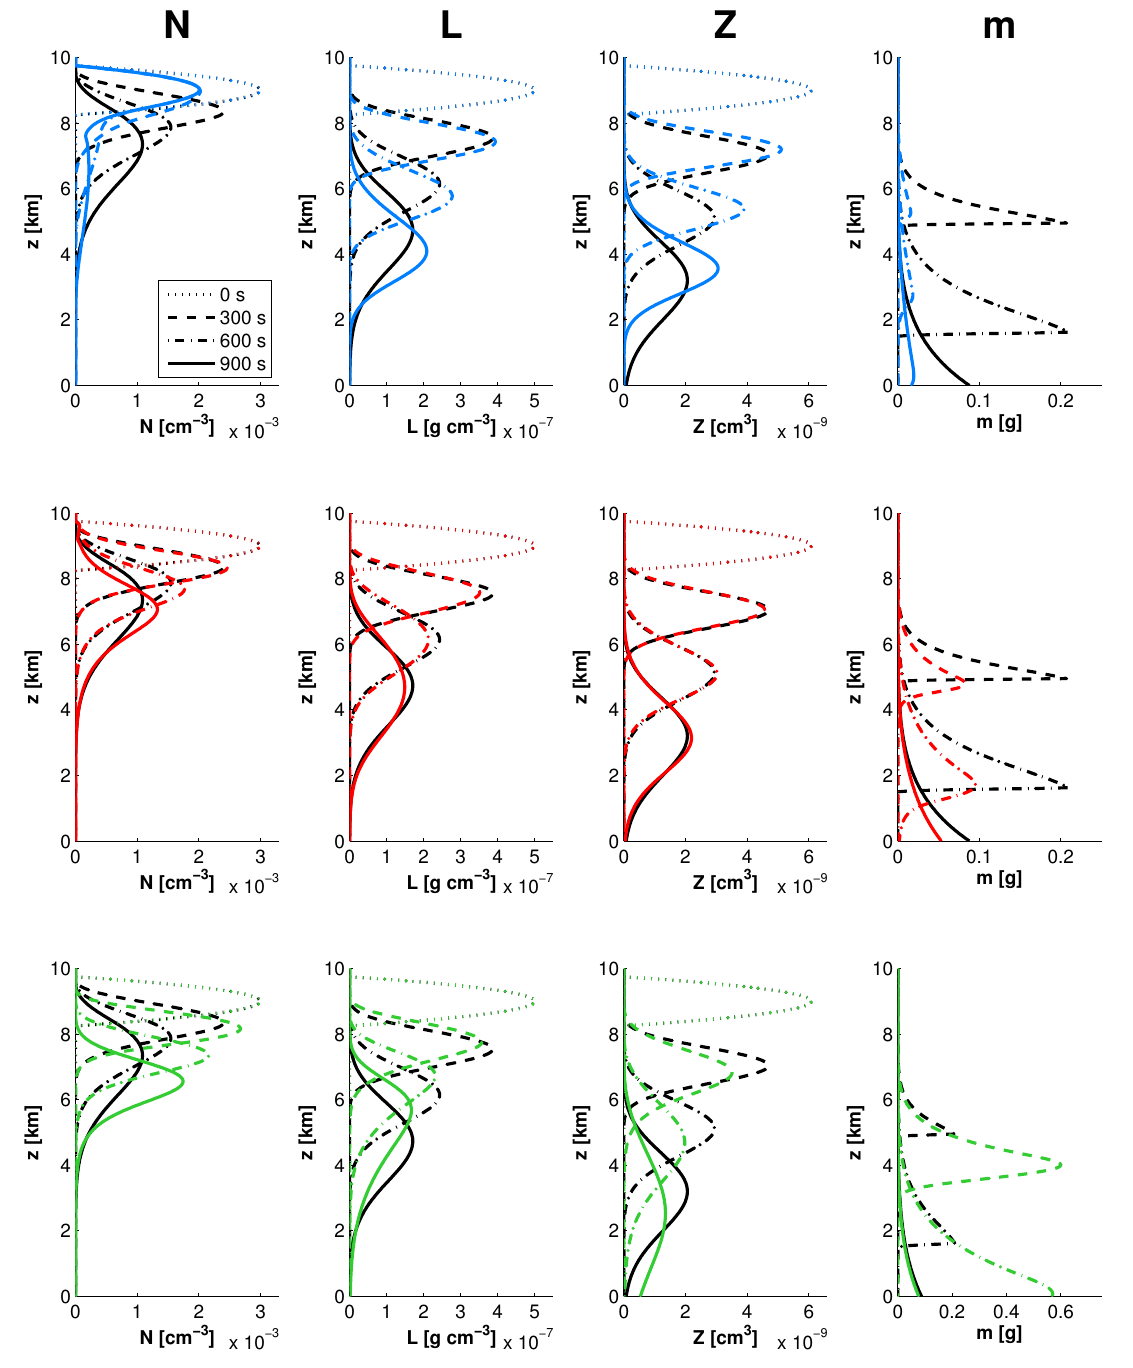
Figure 3. Profiles of N , L , Z and m for the initialization of the model with a parabola-shaped signal (PAR case); see Section 3.3. Spectral reference solution (black), MOM3- B (blue,top), MOM3- Γ (red,middle) and MOM3-log-normal (green,